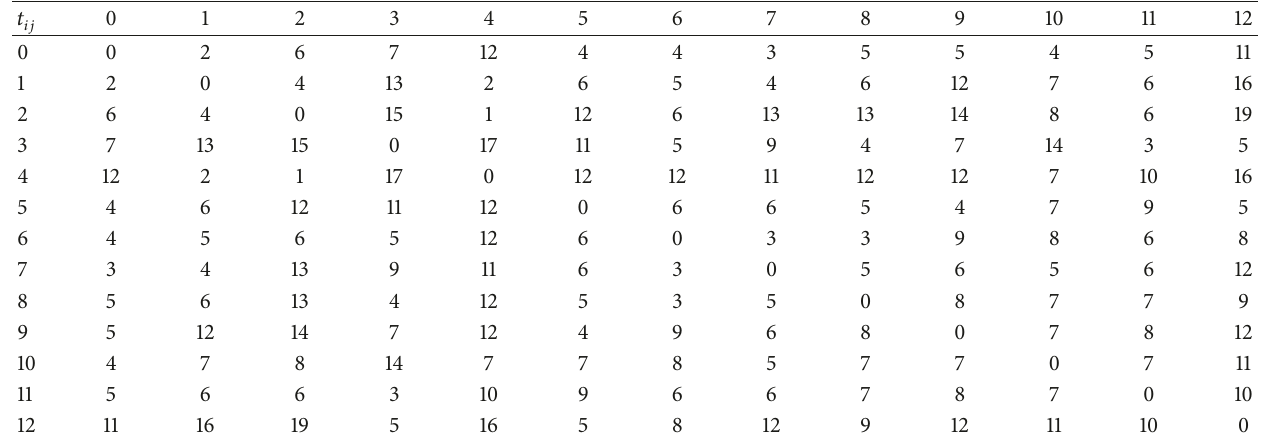
Table 5: 12-node travel time matrix for each point (unit: min).